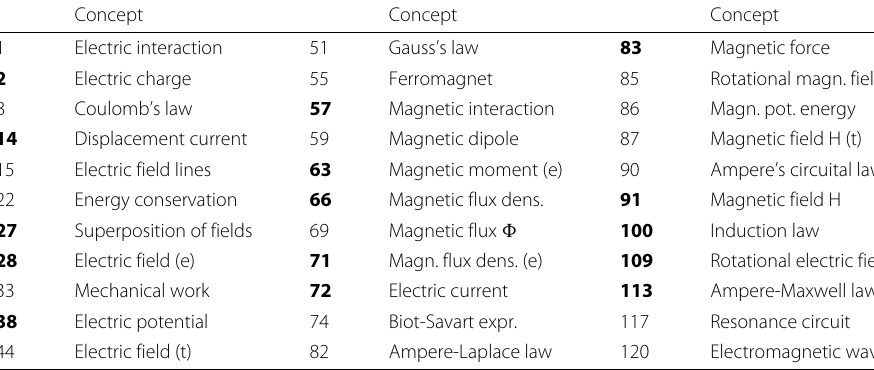
Table 1 Key concepts appearing in students’ concept